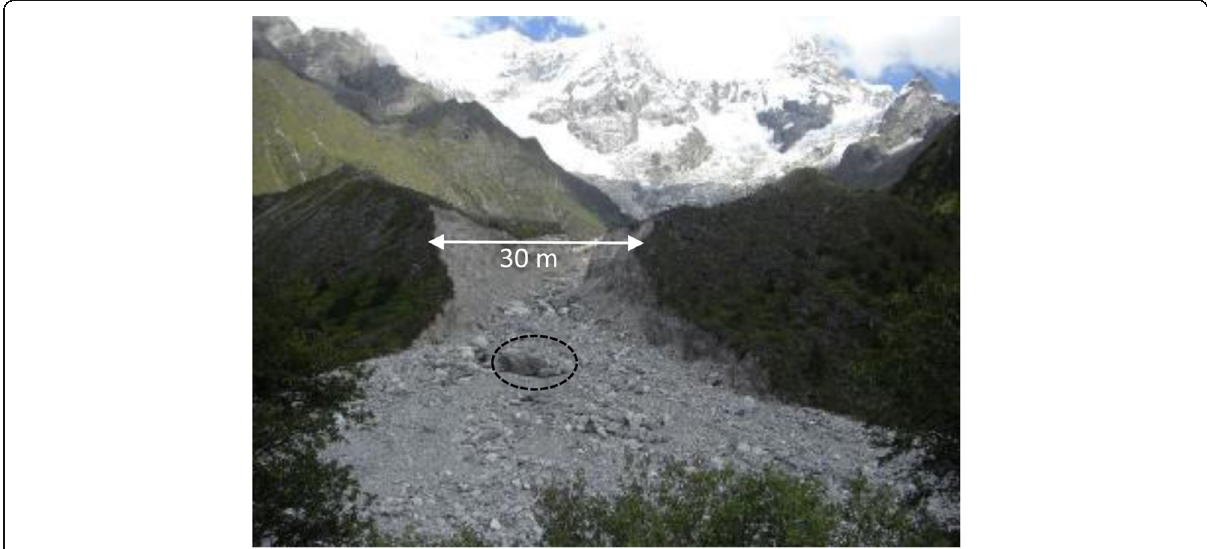
Fig. 5 Frontal view of the typical V-shaped channel morphology after the breach. A large dislodged boulder can be seen in front of the breached